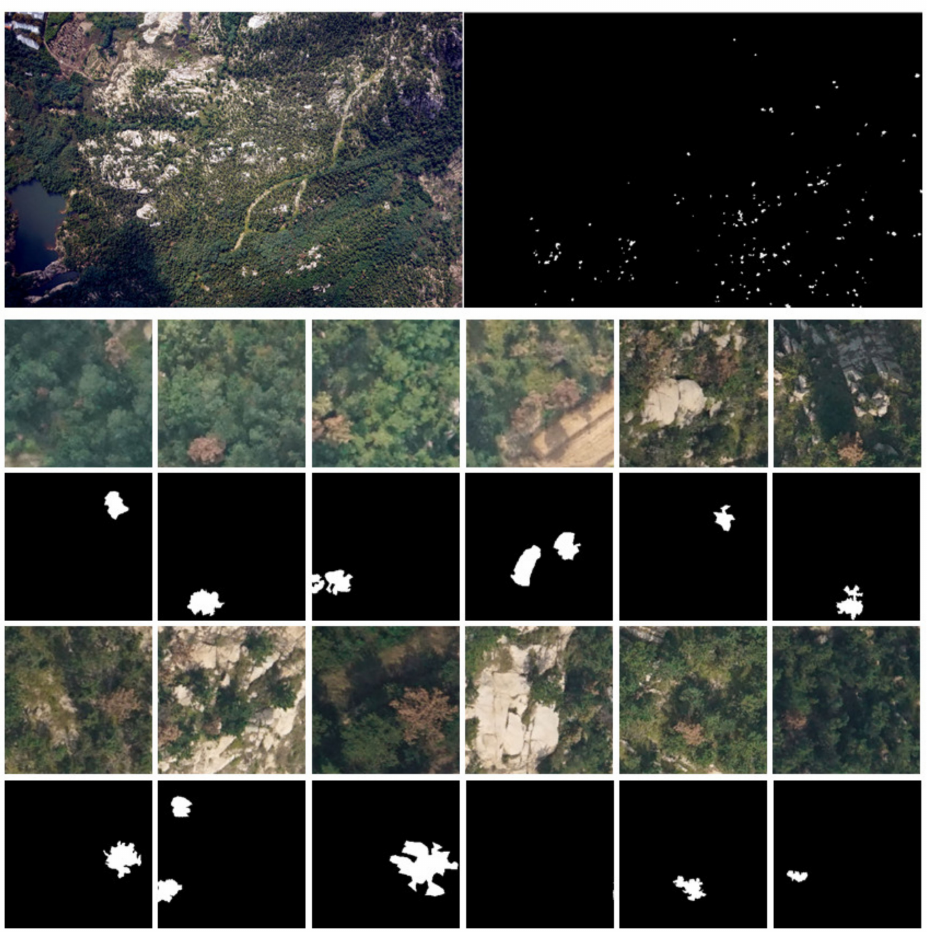
Figure 3. Annotation results of infected pines, the full UAV image and the result of annotation (first-row), and the clipped samples (other